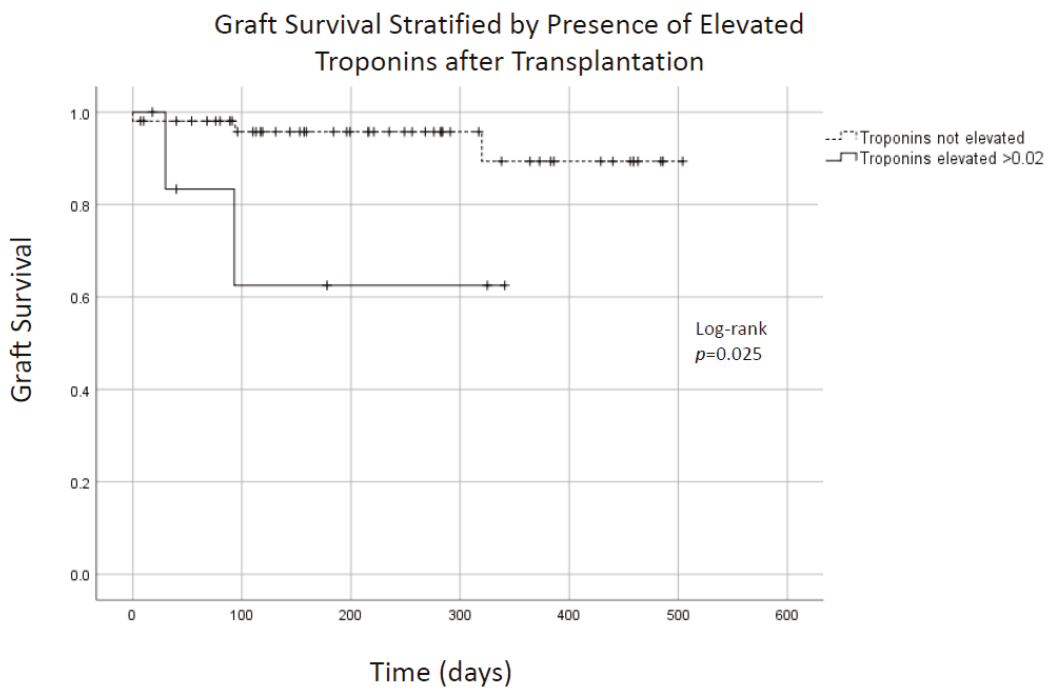
Figure 1. Patient and graft survival for recipients of pancreas transplants. ( A ) patient survival. ( B ) graft survival.